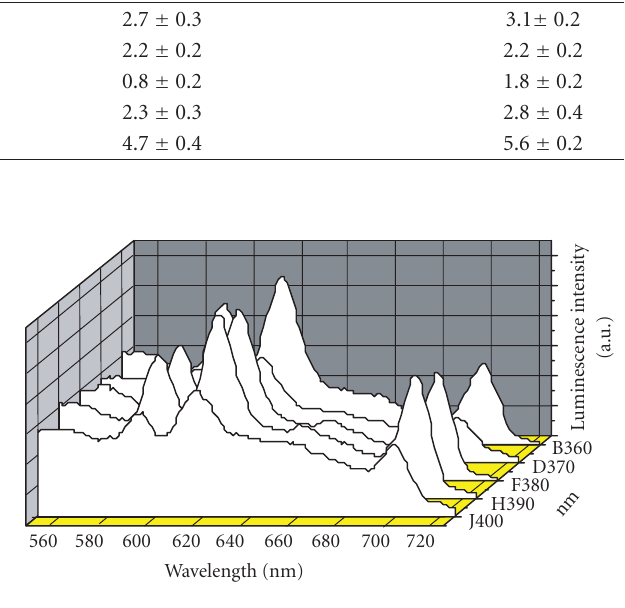
Figure 6: Luminescence emission spectra of 7 × 10 − 4 M of Tb 3+ in the presence of 3 × 10 − 5 M of SP in [PMMA = 8gm / 25ml] at λ = (1) 340nm, (2) 350nm, and (3) 380nm, after two weeks of ex mixing.